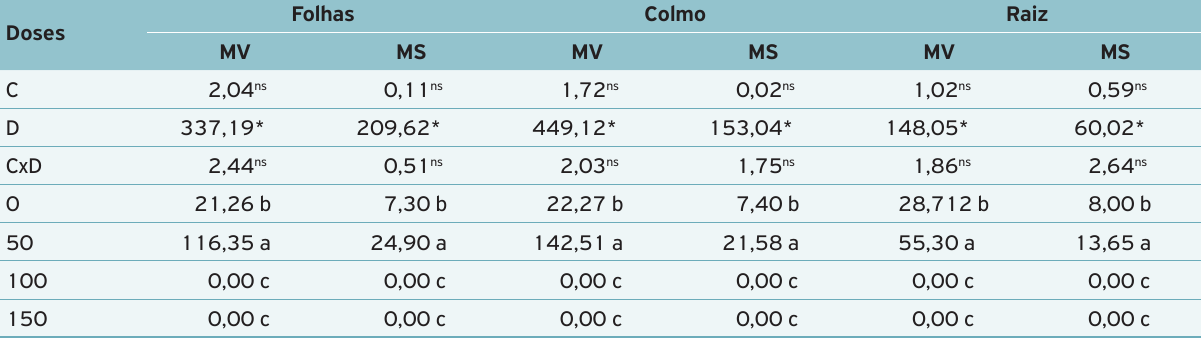
Tabela 2. Análise de variância e valores médios da massa de matéria verde fresca e seca de folhas, colmo e raiz de cultivares de Brachiaria brizantha sp. submetidos a diferentes doses de biofetilizante de